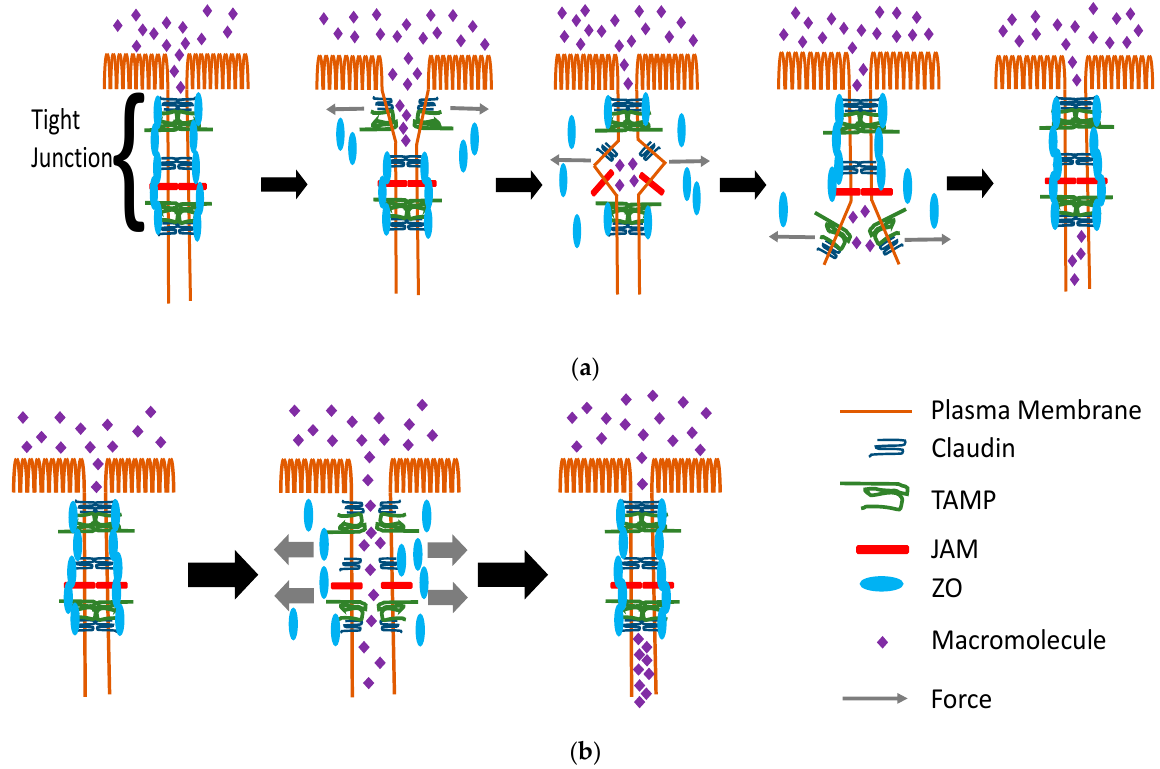
Figure 2. Illustrations of alternative mechanisms of Leak Pathway permeability. ( a ) Breaks in individual tight junction strands enable the progressive movement of macromolecules from a donor fluid compartment to a receiver fluid compartment, passing from one intra-tight junction compartment to the next via the strand breaks. This leads to bursts of macromolecules entering the receiver fluid compartment. ( b ) The entire tight junction structure is disrupted at a specific locus leading to formation of a continuous opening joining the donor and receiver fluid compartments. Macromolecules move through this opening from one compartment to the other in a steady stream until the opening is resealed.